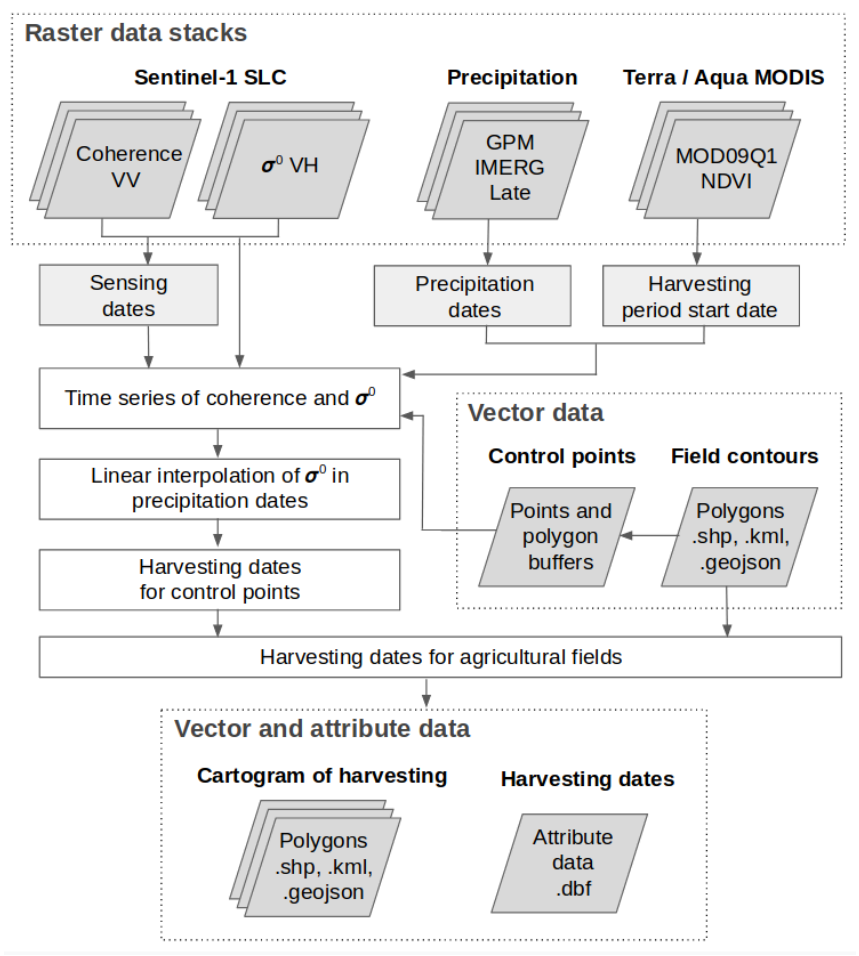
Figure 5. Stages of the algorithm for determining the date of a field